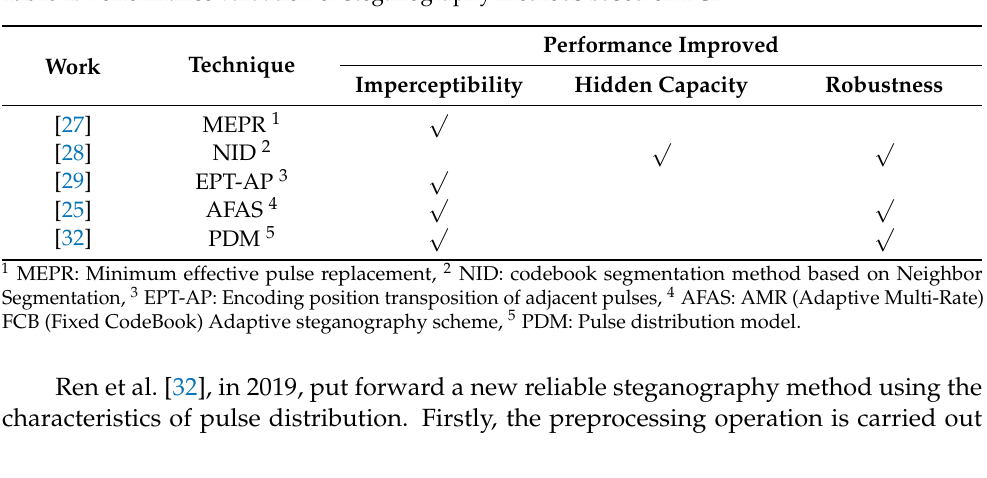
Table 4. Performance valuation of steganography methods based on